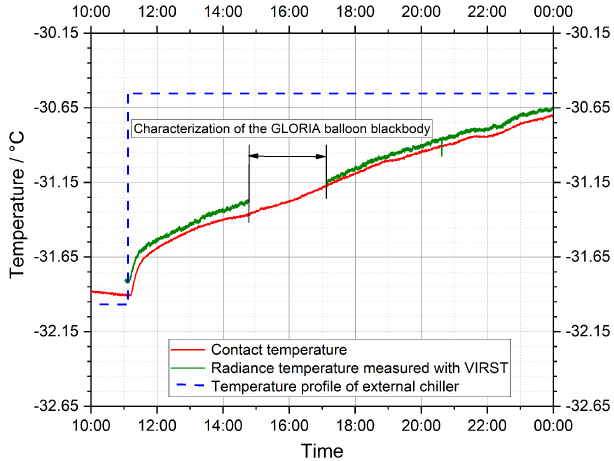
Figure 7. Lateral radiance temperature distribution of the large- area blackbody, recorded during phase change, featuring a non- uniformity of less than 100mK (peak-to-peak). Data availability. Data are presented throughout the text. Test re- sults can be found directly in Figs. 4, 6, and